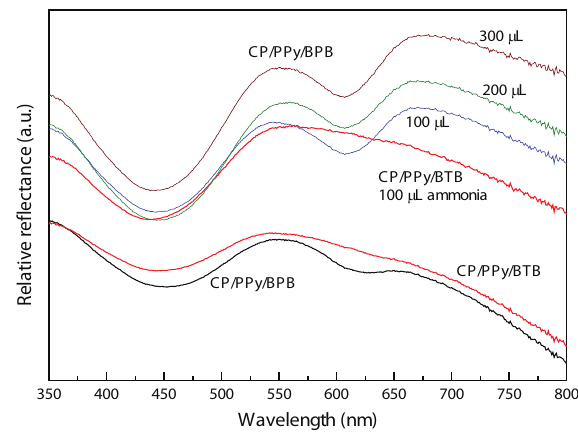
Figure 8: DRS curves for CP/PPy/BPB before and after adding 100 m L (10 ppm), 200 m L (20 ppm) and 300 m L (30 ppm), and CP/PPy/BTB, 100  L (10 ppm) de